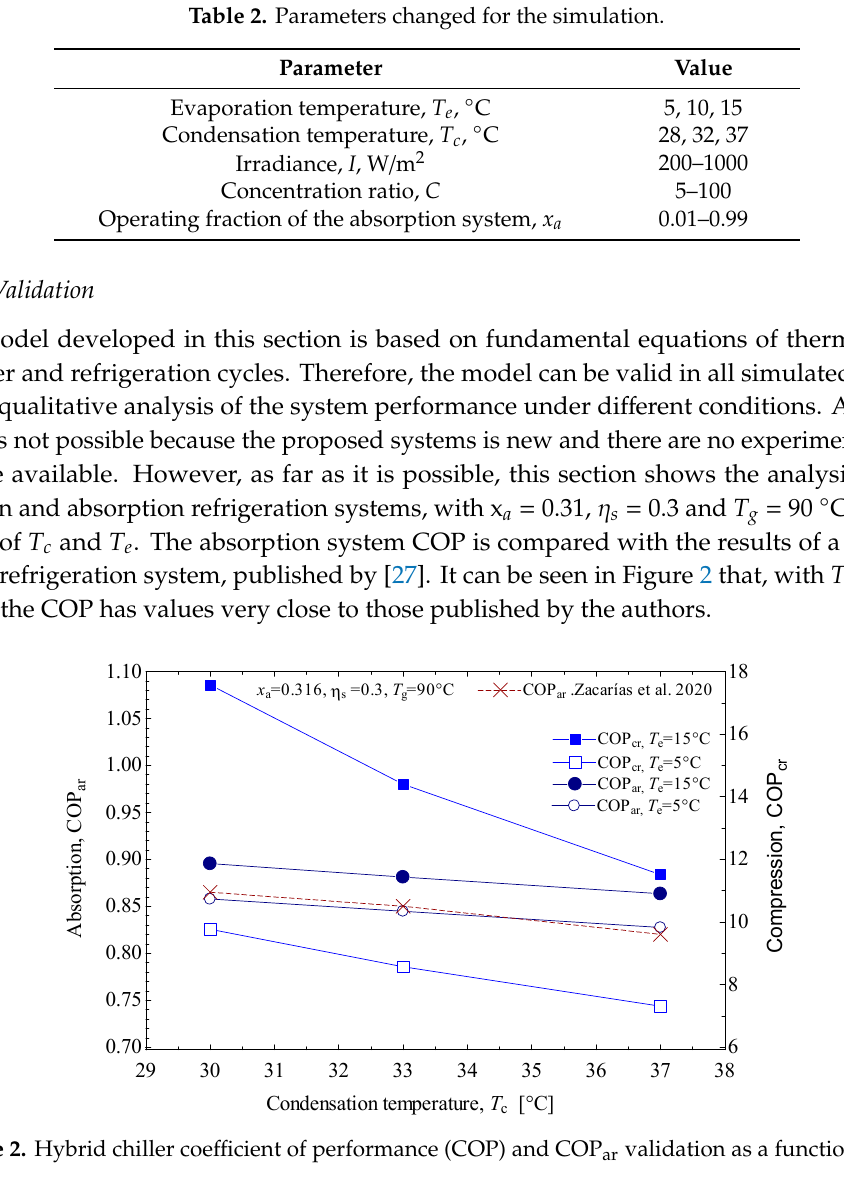
Figure 3. Cooling and supply heat in the hybrid chiller relative to the operating ratio of the cooling systems, x a .